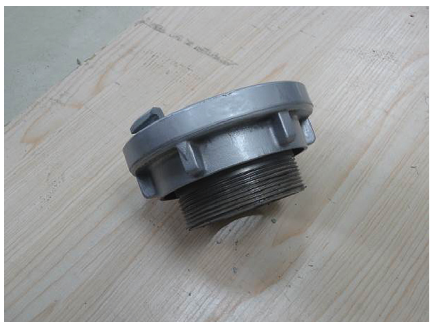
Figure 30: Joint assembly.